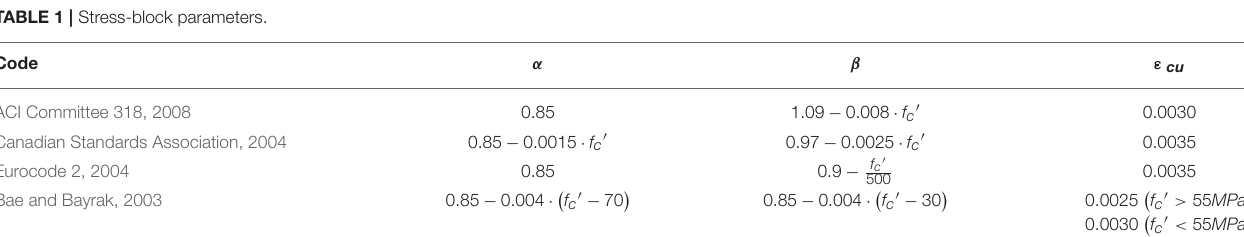
TABLE 1 | Stress-block